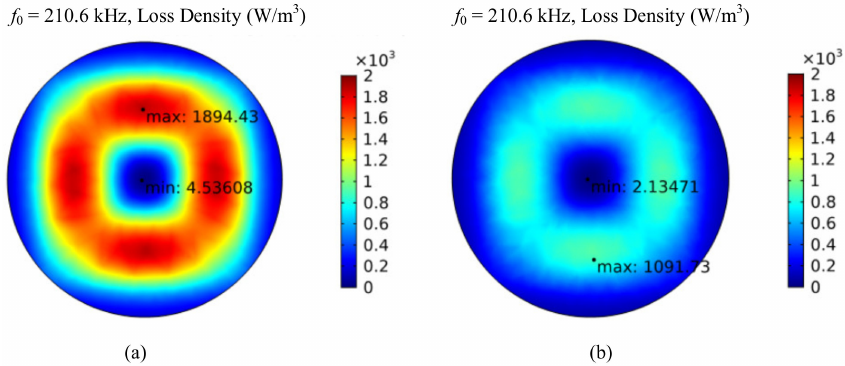
Figure 7. The loss density distribution of the IPT system. ( a ) SS topology; ( b ) SN